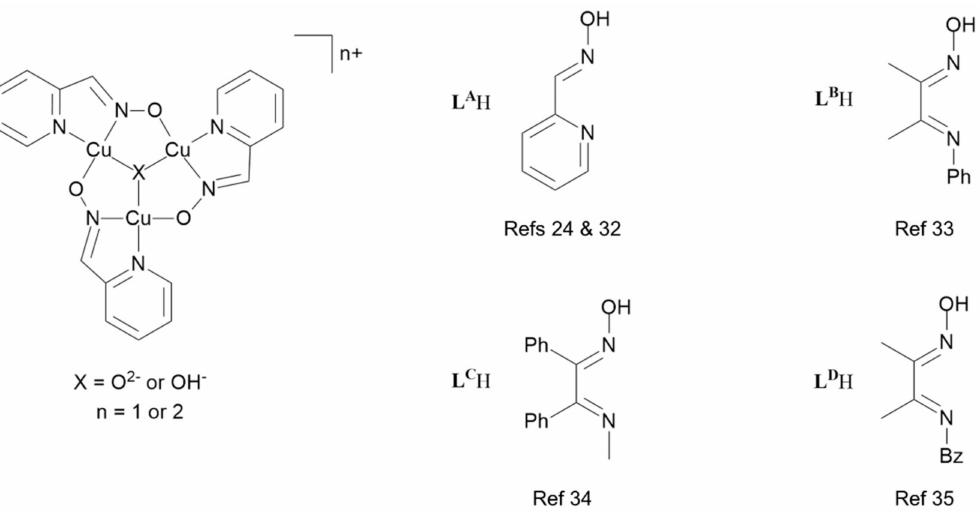
Figure 5. A representation of the Cu 3 O and Cu 3 OH cores present in complexes formed by 2-pyridinaldoxime, L A H [26,34], and some related α -imino-oximes ( L B H– L D H) [35–37] which have only one ionizable H